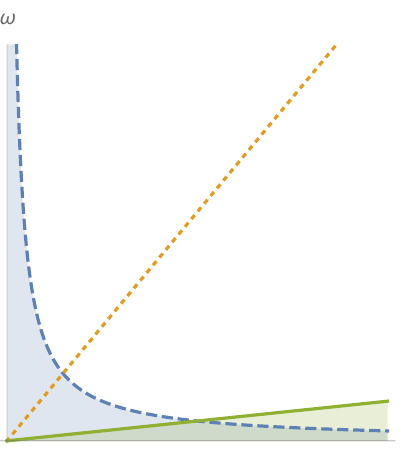
Figure 1 . Validity regions of SUGRA and SYM calculations. In blue region, the nonrelativistic condition, ! (cid:28) 1 =r , is satis(cid:12)ed and our SUGRA calculation is valid. On the other hand, in the green region, the SYM calculations in terms of !l 2 =r expansion is valid. We also depicted a line s p of ! = 2 r= 3, beyond which an instability may occur (see discussions in section 5). Thus, our analysis is valid in the overlapping region near the ! = 0